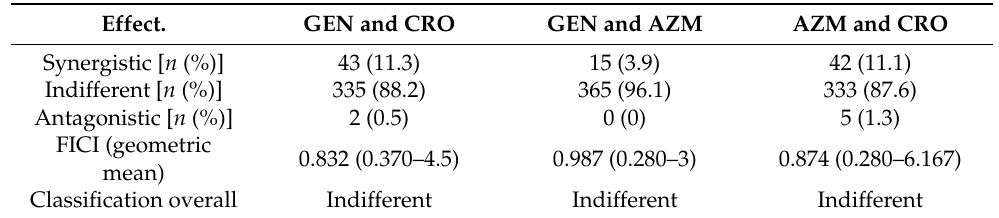
Table 2. Synergy testing results for three combinations (gentamicin plus ceftriaxone, gentamicin